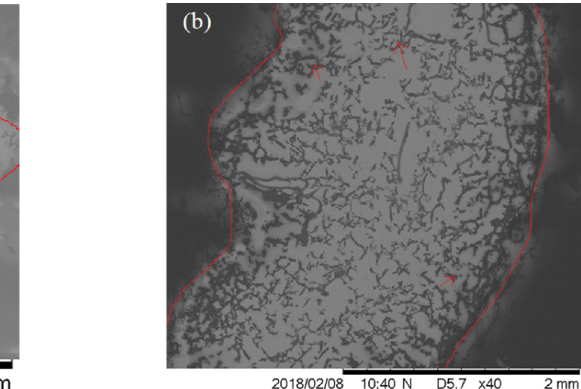
Figure 5. Surface topographical images of the ( a ) PEGDA-PCL, ( b ) SA-PCL, and ( c ) CG1-PCL specimen collected using a scanning electron microscope. The scale bar for all images is 500 µm.